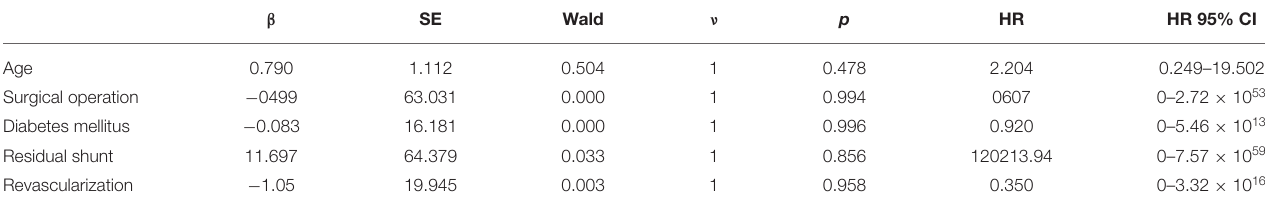
TABLE 6 | Risk factors for death at